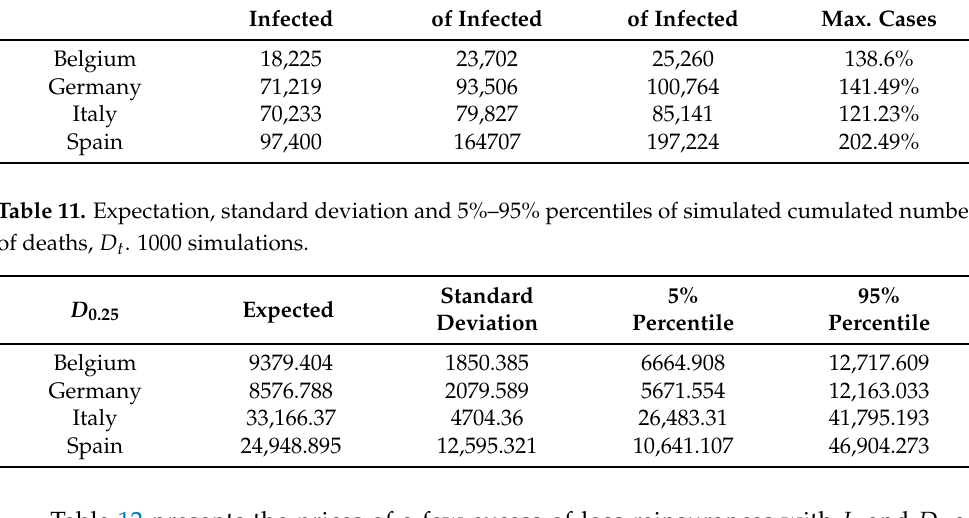
Table 12 presents the prices of a few excess-of-loss reinsurances with I t and D t